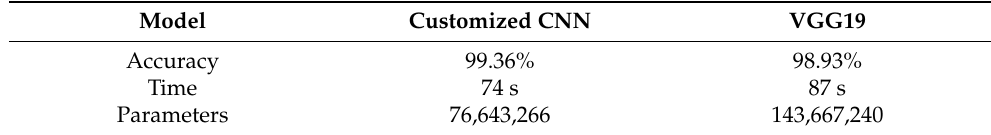
Table 4. Training accuracy and training time of each network model.